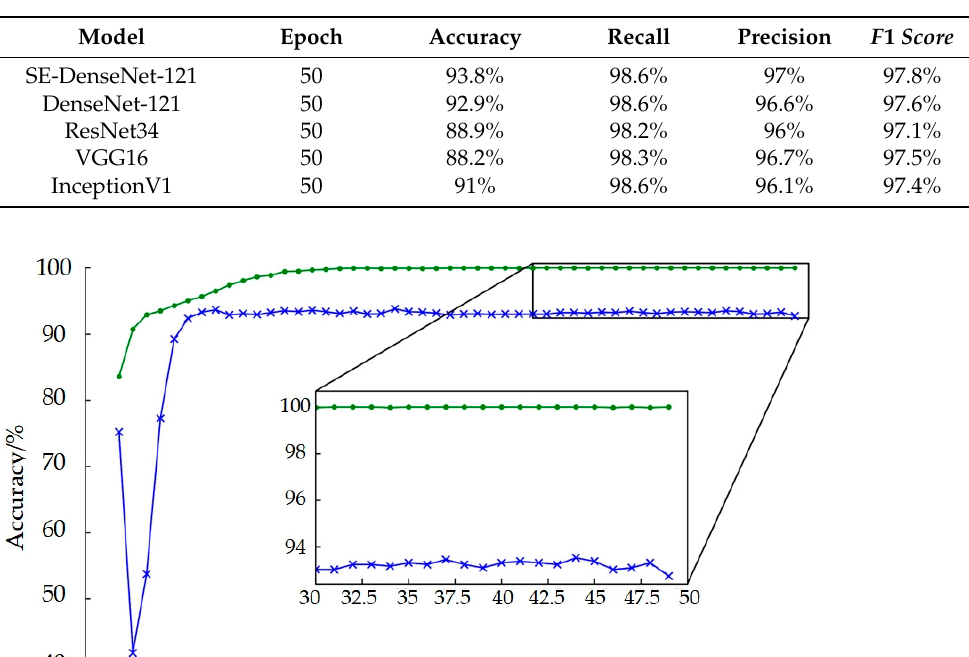
Table 5. Performance comparison of different models.